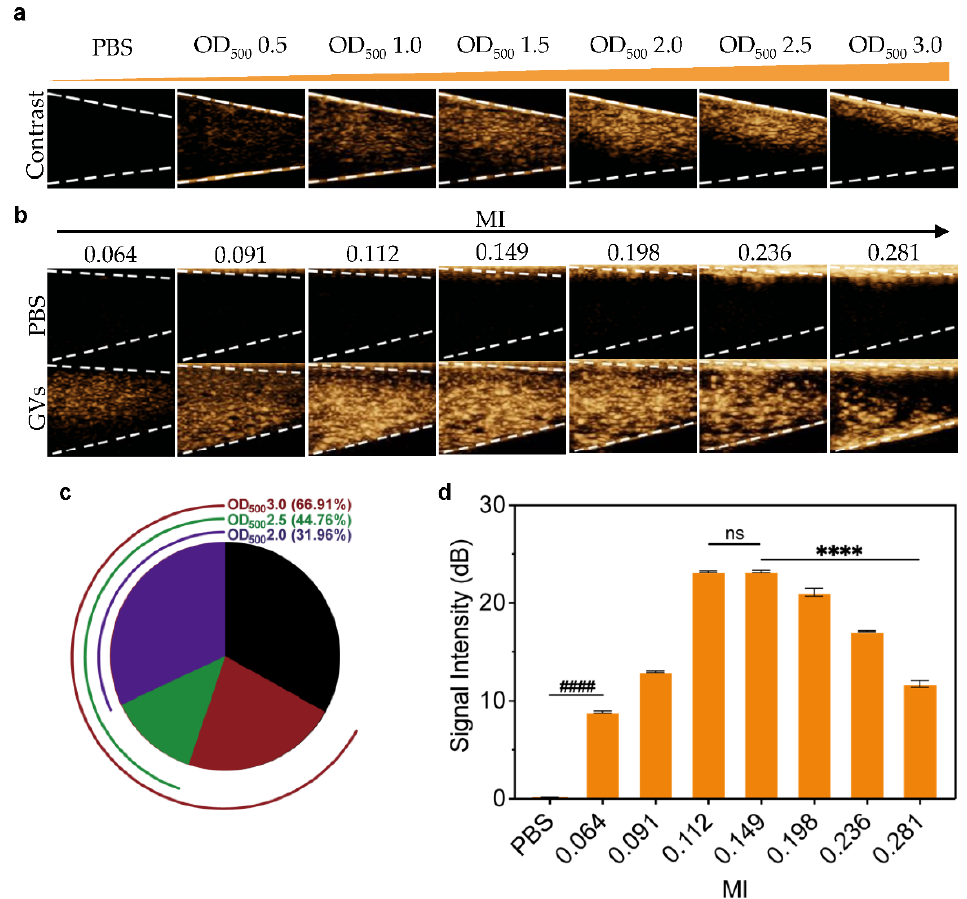
Figure 2. Ultrasound contrast imaging of GVs in vitro: ( a ) nonlinear contrast images acquired by a linear array transducer of GVs at different concentrations (OD 500 0.5–3.0); ( b ) nonlinear contrast images of 200 μ L GVs at OD 500 1.5 and 200 μ L PBS, when the MI was changed from 0.064 to 0.281; ( c ) the percentage of acoustic attenuation area produced by GVs at OD500 2.0 (purple), OD500 2.5 (green), and OD500 3.0 (red); ( d ) contrast signal intensity produced by GVs at different MI. Error bars represent ± SD. **** p < 0.0001. #### p < 0.0001. ns, no statistical significance.